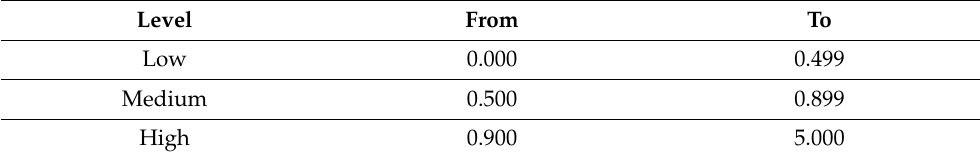
Table 3. Range classification for raw